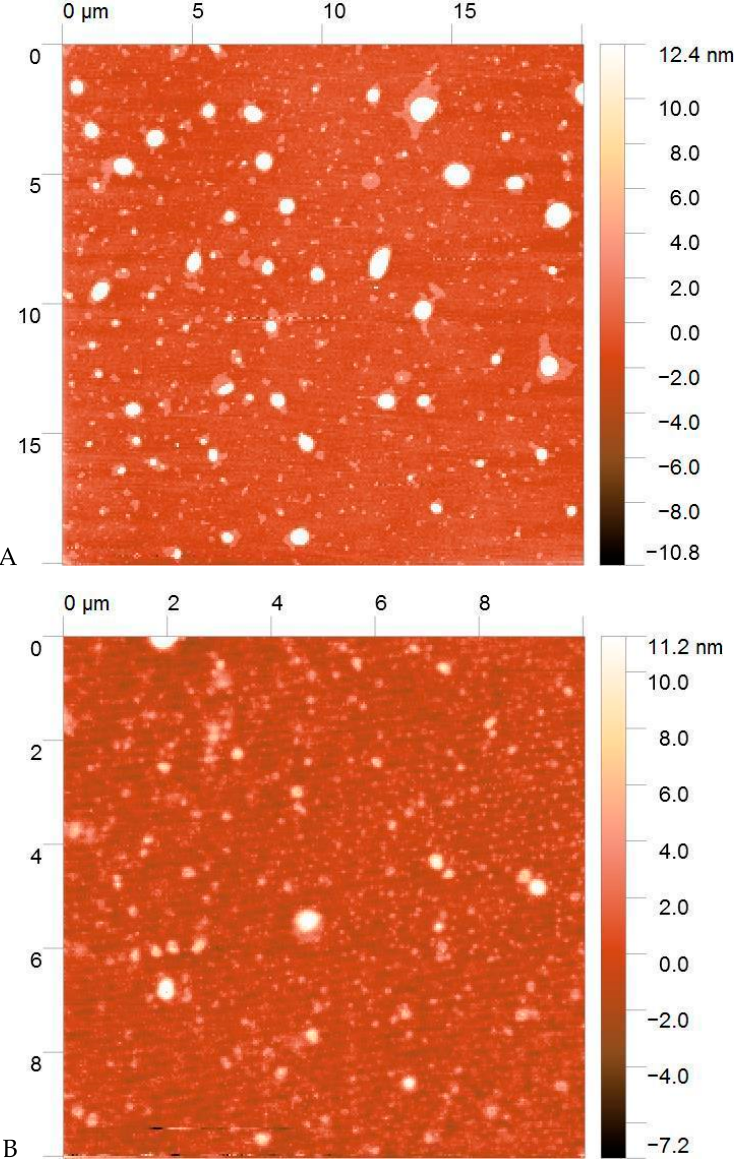
Figure 2. Atomic force microscopy (AFM) images of Formulation 1 ( A ) and Formulation 5 ( B ).